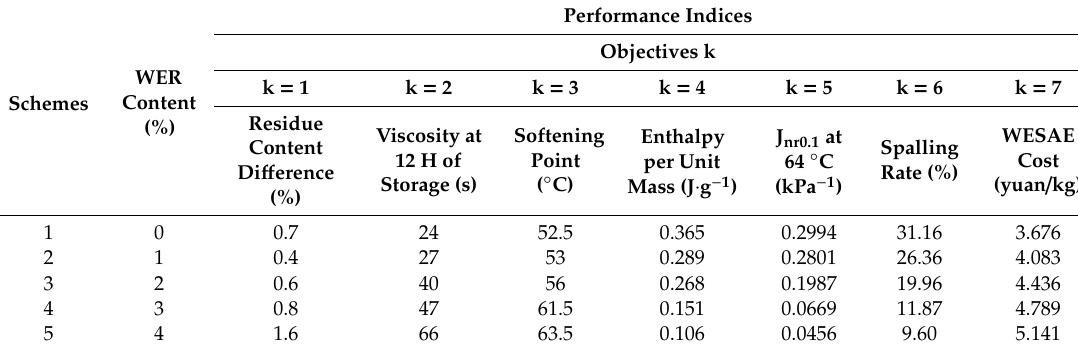
Table 7. Data for multiobjective gray target